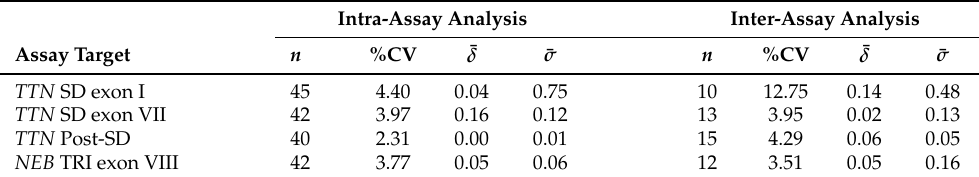
Table 3. Intra- and inter-assay analysis results, including n , %CV, mean difference ( ¯ δ ) and mean σ (¯ σ ) for each ddPCR